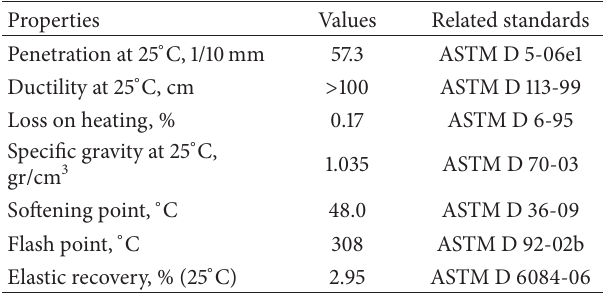
Figure 4: Variation in air voids and unit weight with respect to rubber content. Table 3: Properties of